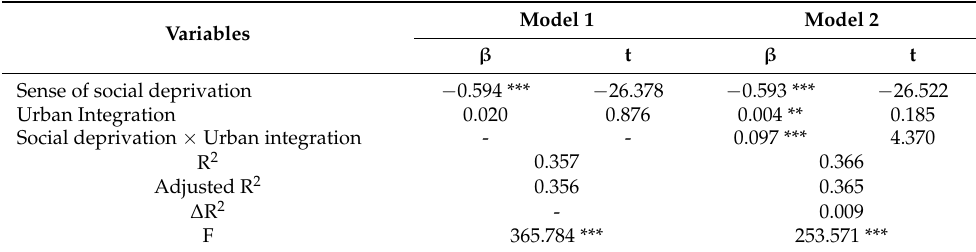
Table 11. Test of the moderating effect of urban integration between perception of social deprivation and social